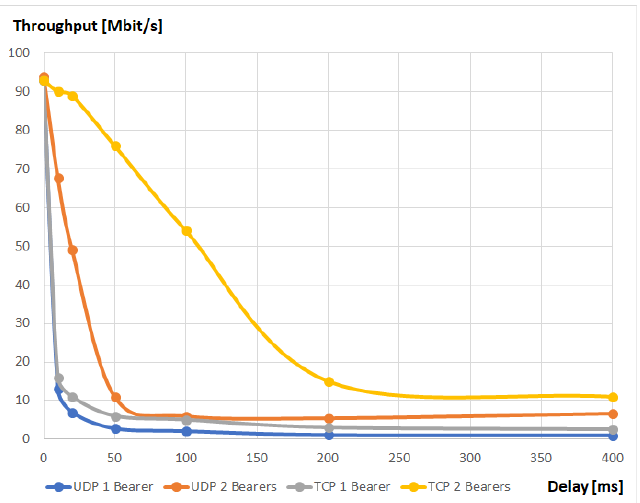
Figure 17. Data Transfer Throughput vs. Increasing Latency with fixed Packet Loss equal to 1% on Bearer